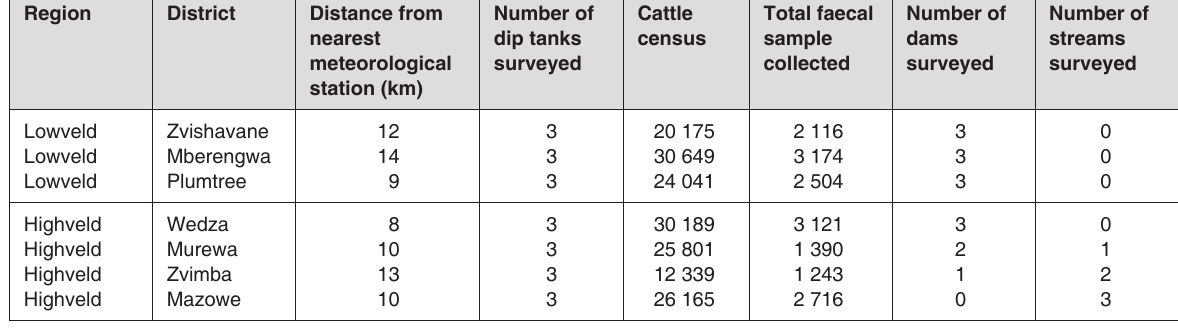
TABLE 1 Study sites, cattle census and total samples collected in the highveld and lowveld communal grazing areas of Zimbabwe for the period January 1999 to December 2000